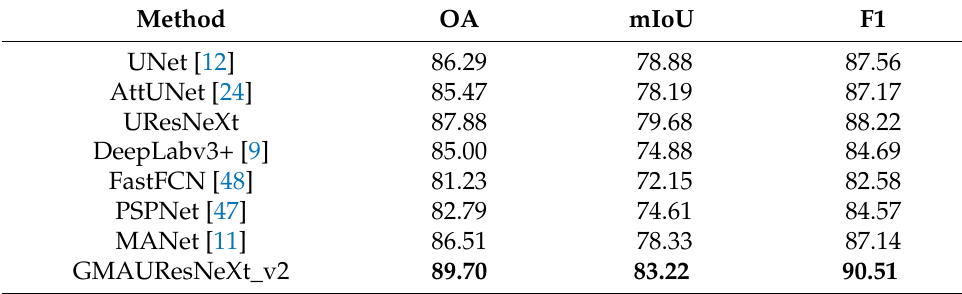
Table 2. The experimental results on the GID